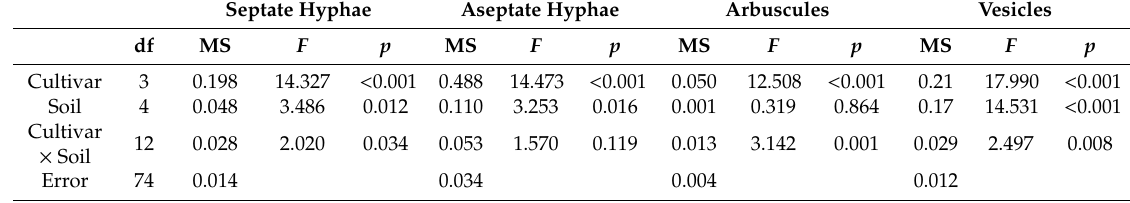
Table 5. ANOVAs for fungal root colonization (septate hyphae, aseptate hyphae, arbuscules, vesicles) as a function of plant cultivar, soil inoculum source, and their interaction.